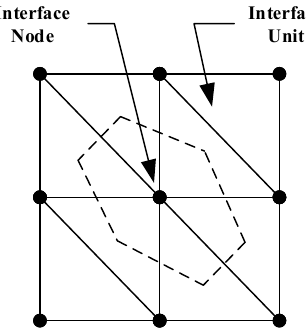
Figure 4. Interface node-related area distribution.